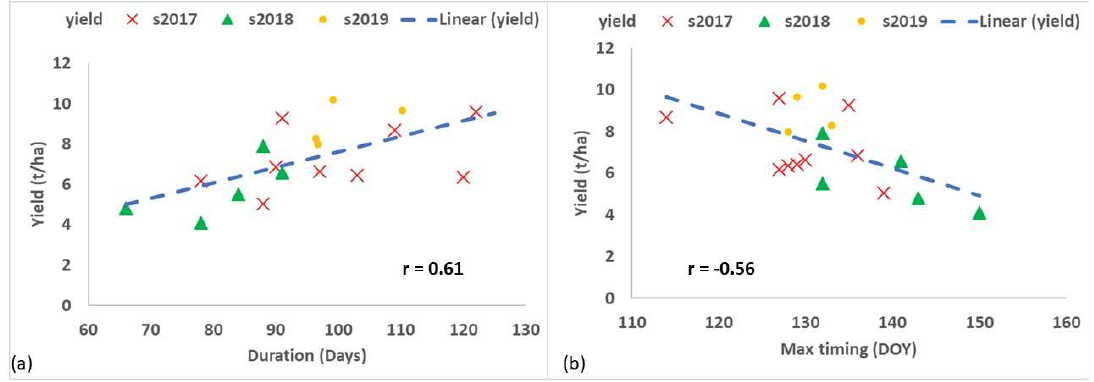
Figure 10. Scatter plot showing the relationship between Yield and ( a ) Duration and ( b ) the timing of the maximum value of VH / VV (Tmax). The r value and best fit linear line for each relationship, across the three seasons, is shown.